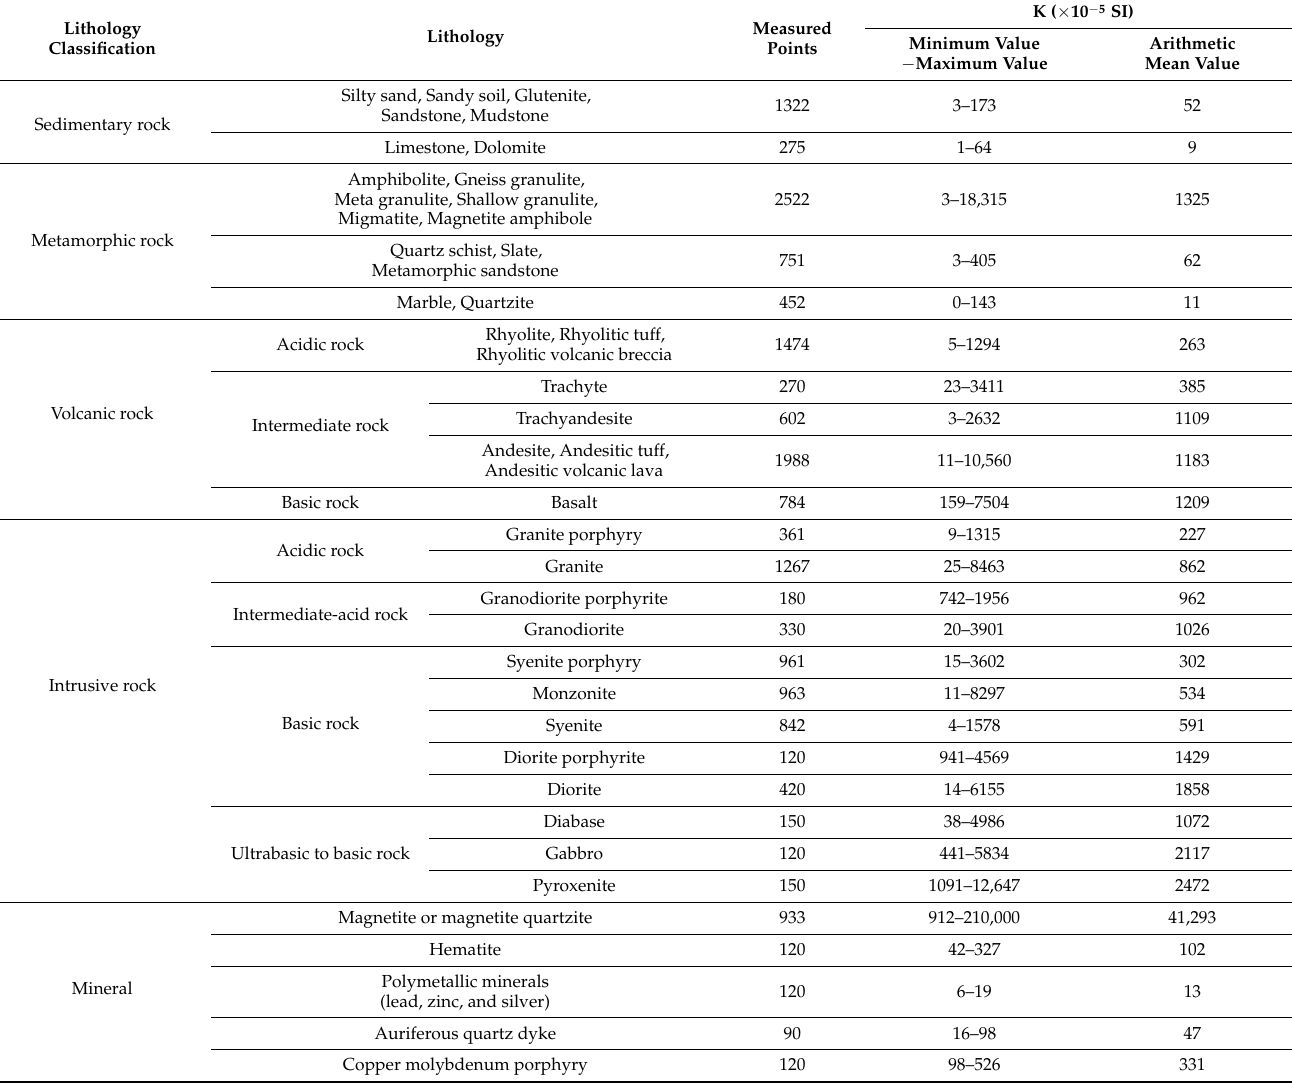
Table 1. Magnetic statistics of measured rock (ore) in the study